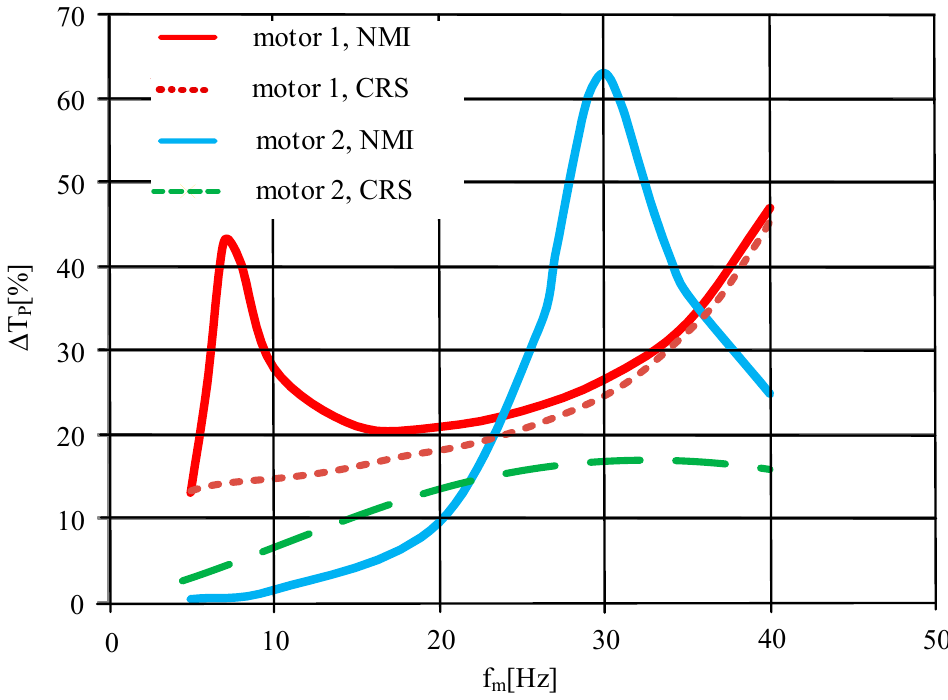
Figure 18. Pulsating torque component Δ T p of the frequency described with (21), (22) versus the frequency of the voltage modulation for the phase modulation ( ϕ sh = 0°, ϕ ih = 180°).